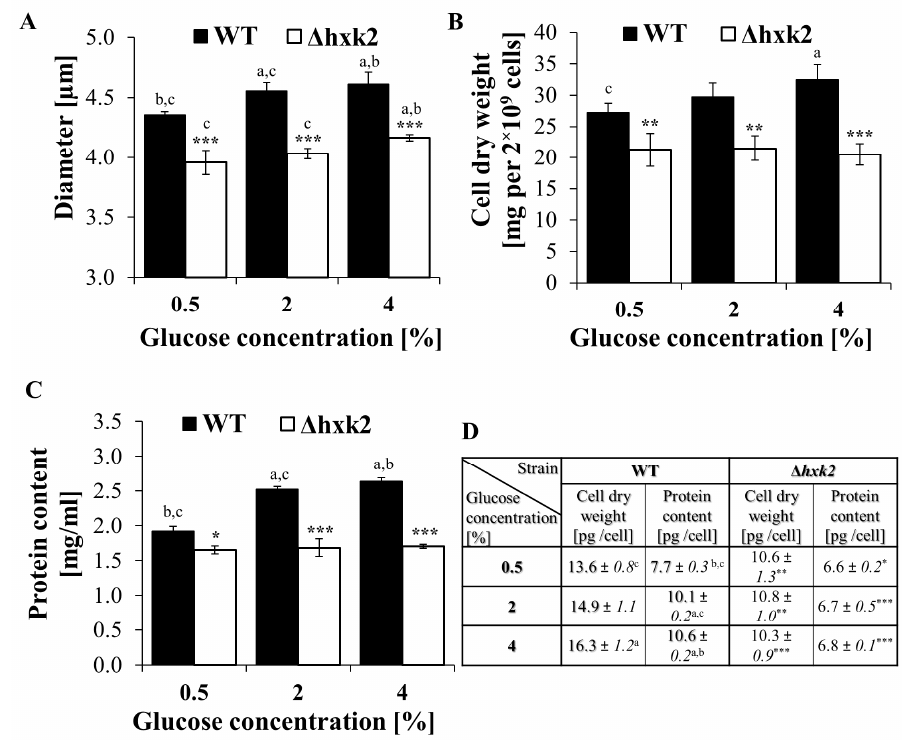
Figure 5. Parameters connected with biosynthetic capabilities of yeast cells cultured in conditions with different glucose concentration. ( A ) The cell size of yeast cells cultured in conditions of different glucose concentrations. Diameter of the cells was estimated through analysis of microscopic images using the cellSens Dimension software; n = 300 cells; ( B ) cell dry weight determined using moisture analyzer. The data present cell dry mass from three independent experiments where 2 × 10 9 cells each were used; ( C ) protein content in cell extracts obtained from strictly defined number of cells (5 × 10 8 yeast cells from the exponential phase culture); ( D ) comparison of cell dry weight and protein content expressed in the same unit per cell. The results are presented as mean ± SD from three independent experiments. * p < 0.05, ** p < 0.01, *** p < 0.001 as compared to the WT strain; a—different to medium with 0.5% glucose, b—different to medium with 2% glucose, c—different to medium with 4% glucose.